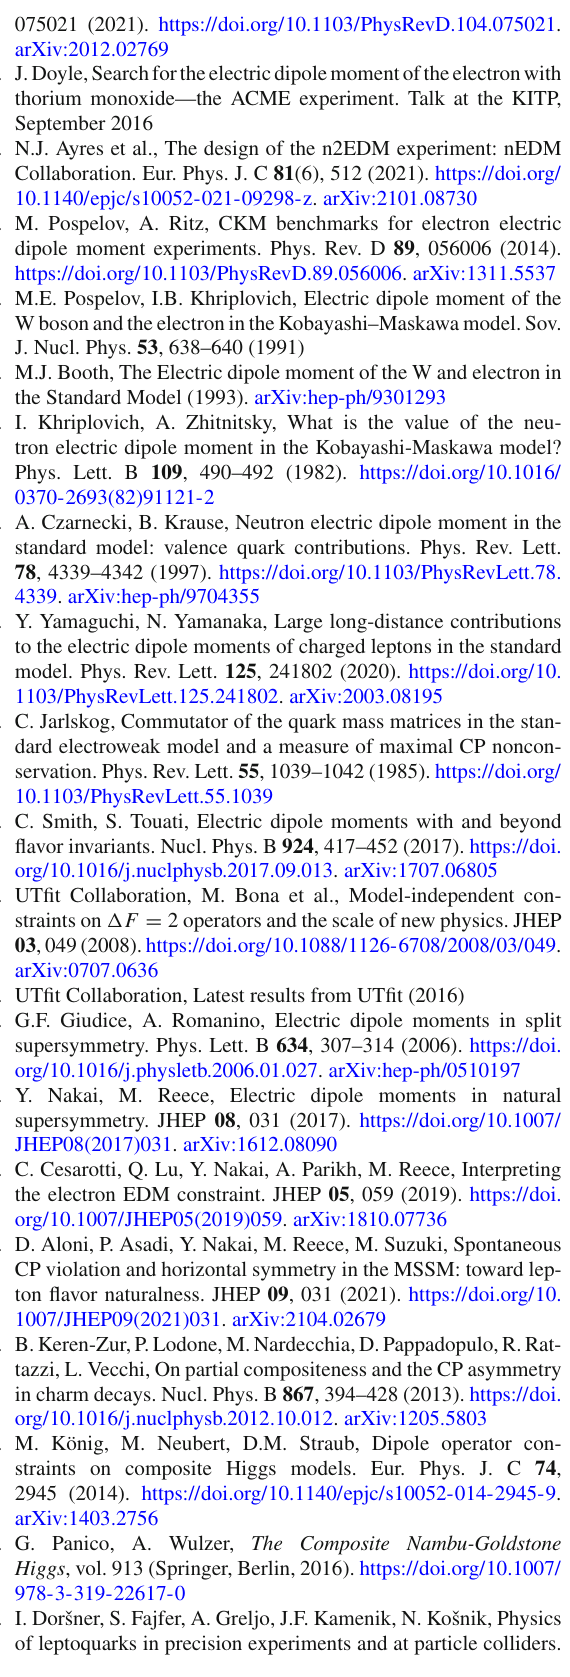
Table 15 Lower bounds on the UV scale (cid:2) in TeV assuming C X ( Y )